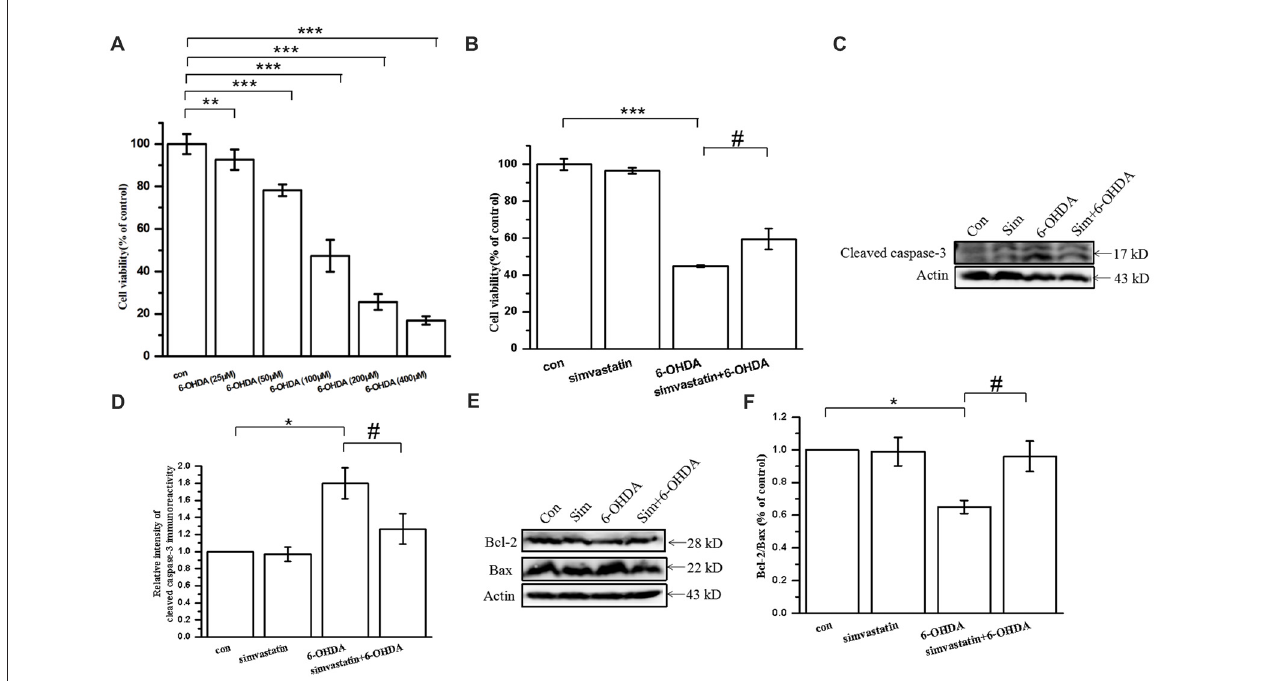
FIGURE 1 | Simvastatin protected against 6-hydroxydopamine (6-OHDA)-induced cytotoxicity in SH-SY5Y cells. (A) SH-SY5Y cells treated with different concentration of 6-OHDA and cell viability determined after 24 h using a CCK-8 kit. (B) SH-SY5Y cells co-treated with 1 µ mol/L simvastatin and 100 µ mol/L 6-OHDA; cell viability determined after 24 h using a CCK-8 kit. (C) After 12 h co-treatment, expression of cleaved caspase-3 detected by western blot. (D) Relative quantitative analysis of cleaved caspase-3 expression. (E) Expression of Bcl-2 and Bax detected by western blot after 24 h co-treatment. (F) Analysis of the Bcl-2/Bax ratio. Data were obtained from three independent experiments. Statistical analysis was by Dunnett’s T3 test or least significant difference (LSD) post hoc test based on analysis of variance (ANOVA); data expressed as mean ± standard error of the mean (SEM). ∗ P < 0.05, ∗∗ P < 0.01, ∗∗∗ P < 0.001, # P < 0.05.